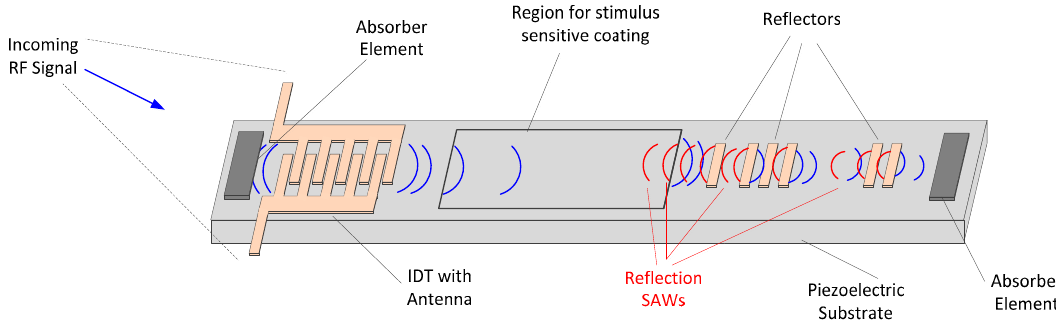
Figure 2. Basic Surface Acoustic Wave (SAW) Sensor.